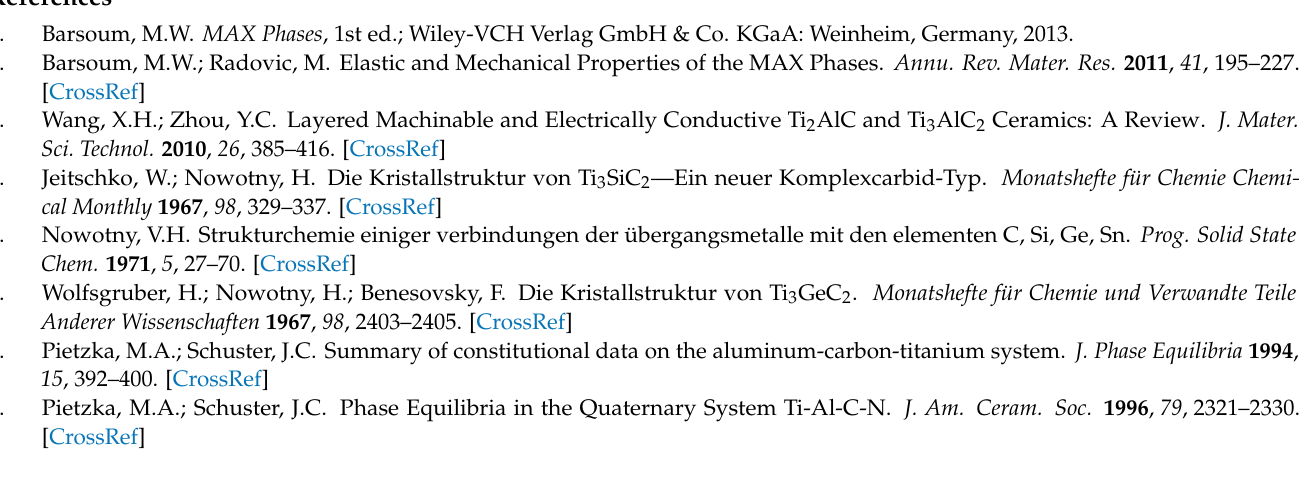
internal coordinates. Table S2: Optimized k-point grids for bulk MAX phases. Table S3: Optimized cut-off energies for bulk MAX phases. Table S4: Literature and manually fitted lattice parameters. a × c represents the a and c lattice parameters